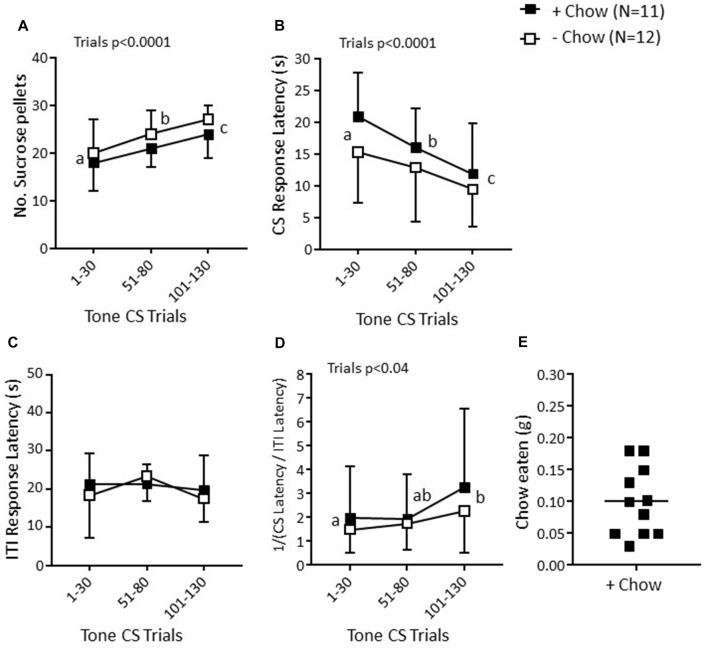
Effects of provision of a chow pellet on behavior in the RST in non-manipulated mice in Experiment 2. Scores are for the first 30 trials per session on three consecutive days. (A) Number of sucrose pellets obtained. (B) Mean response latency to a tone CS (maximum duration 30 s) associated with pellet availability. (C) Mean response latency in the inter-trial intervals (ITI, 50 ± 30 s) between successive CS. (D) Mean CS/ITI reciprocal ratio. Values are overall mean ± SD. Significant statistical effects indicated were obtained with mixed factorial ANOVA; trials denoted with different letters were significantly different in post hoc Bonferroni tests. (E) In the +Chow group, scatter plot and overall mean for the mean weight of chow eaten during the three test sessions.